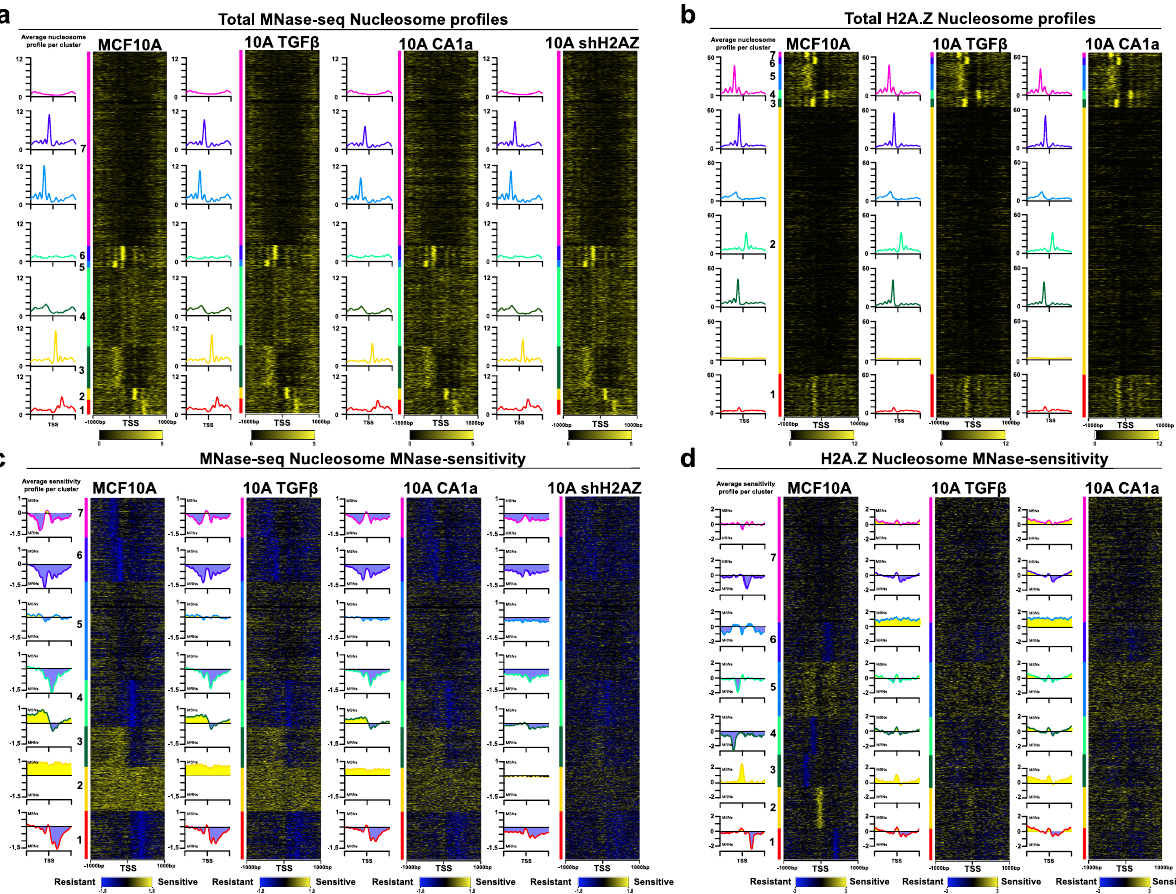
Fig. 1 Comparison of the nucleosomal organisation and MNase sensitivity of all human promoters in epithelial, mesenchymal and cancer cell types. a Heatmaps displaying total mTSS-seq nucleosome data for all human promoters centred on the TSS (±1 kb). Total nucleosome data for MCF-10A was sorted with k-means clustering ( k = 7), followed by total nucleosome data for MCF-10A + TGF- β , MCF-10CA1a and shH2A.Z MCF-10A on the same sort order. Average pro fi les are shown to the left of the heatmaps for each cluster. The left most heatmap dictates the sort order for all other maps in the panel. b Heatmaps displaying total H2A.Z ChIP-seq data for all human promoters centred on the TSS (±1 kb). Total H2A.Z nucleosome data for MCF-10A was sorted with k-means clustering ( k = 7), followed by total H2A.Z data for MCF-10A + TGF- β , and MCF-10CA1a on the same sort order. Average pro fi les are shown to the left of the heatmaps for each cluster. The left most heatmap dictates the sort order for all other maps in the panel. c The log 2 ratio of light/ heavy MNase digest (MNase sensitivity) for total nucleosomes was determined for all human promoters centred on the TSS (±1 kb). The MNase sensitivity for the MCF-10A MTSS-seq data was sorted with k-means clustering ( k = 7) followed by MNase sensitivity for MCF − 10A + TGF- β , MCF-10CA1a and shH2A.Z MCF-10A on the same sort order. Average pro fi les are shown to the left of the heatmaps for each cluster. The left most heatmap dictates the sort order for all other maps in the panel. MNase sensitivity values for exemplar categories of highly positioned nucleosomes (cluster 6, − 1 MRN and cluster 4, + 1 MRN) are signi fi cantly different in MCF10A compared to each experimental condition (all p -values < 2.2 × 10 − 16 , using a two-sided Welch ’ s t -test assuming unequal variances). d The log 2 ratio of light/heavy MNase digest (MNase sensitivity) for H2A.Z nucleosomes was determined for all human promoters centred on the TSS (±1 kb). The MNase sensitivity for immunoprecipitated H2A.Z-containing nucleosomes in MCF-10A was sorted with k- means clustering ( k = 7) followed by the MNase sensitivity for H2A.Z MCF − 10A + TGF- β , and H2A.Z MCF-10CA1a on the same sort order. Average pro fi les are shown to the left of the heatmaps for each cluster. The left most heatmap dictates the sort order for all other maps in the panel. MNase sensitivity values for exemplar categories of highly positioned nucleosomes (cluster 4, − 1 MRN and cluster 2, MSN at TSS) are signi fi cantly different in MCF10A compared to each experimental condition (all p -values < 2.2 × 10 − 16 , using a two-sided Welch ’ s t -test assuming unequal variances). The clustering window was set to ±500 bp surrounding the TSS for all in Fig. 1a. The same H2A.Z nucleosome positions are observed as for total nucleosome positions indicating that canonical nucleo- somes and H2A.Z-containing nucleosomes mostly occupy the same positions (Supplementary Fig. 4). However, subtle differ- ences are observed e.g. H2A.Z cluster 1 is not observed in the total nucleosome pro fi le nor is the slightly different H2A.Z nucleosomes positioned in the − 1 position.